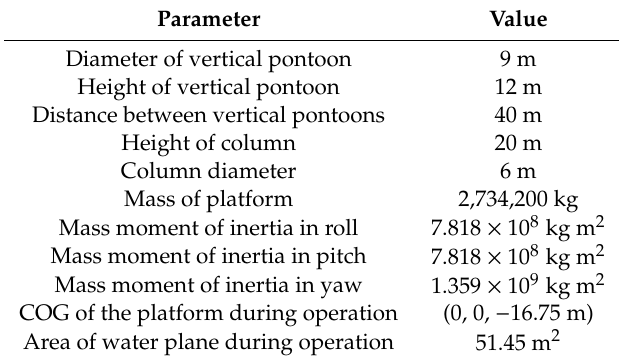
Figure 1. Overall model of the submerged floating offshore wind turbine (SFOWT). Table 1. Main parameters of the floating platform.